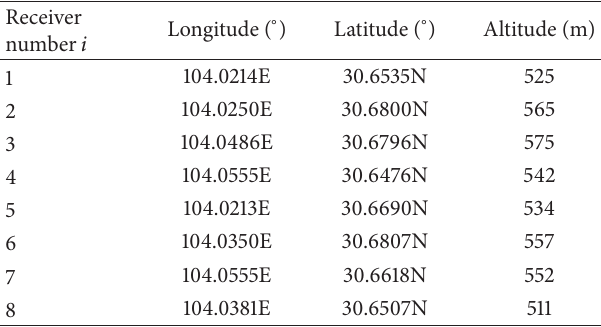
Table 1: True positions of the receivers.